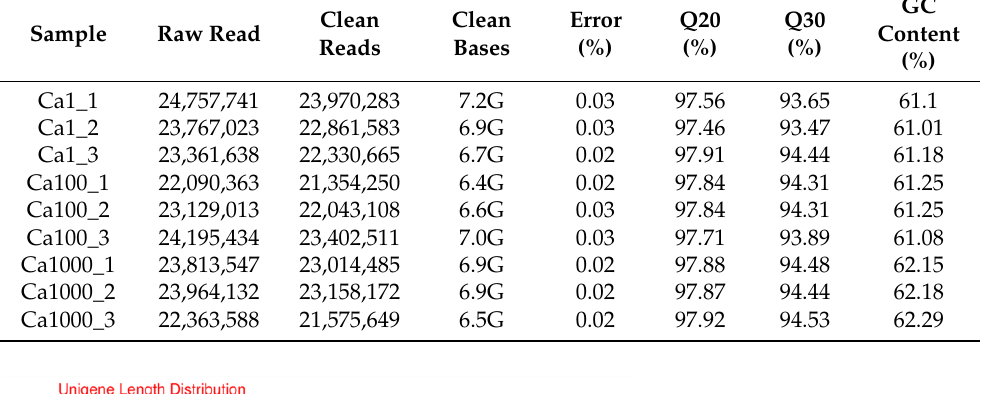
Table 2. Splice length distribution of P. kessleri FACHB-3316.